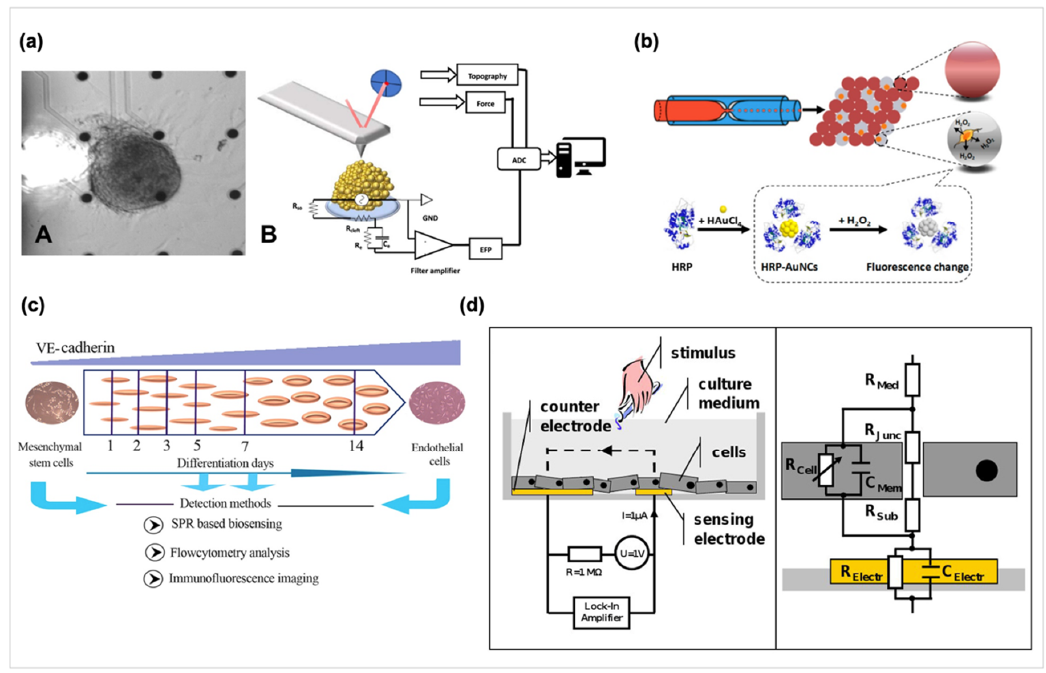
Figure 2. ( a )-A: A beating cardiac cluster placed on a microelectrode arrays (MEA) sensing area. ( a )-B: Schematic representation of the implemented setup (Reprinted with permission from [62] Copyright (2019) ELSEVIER publishing). ( b ) Schematic Illustration of Detecting Hydrogen Peroxide in the Single-Cell Encapsulated Droplets in Combination with horseradish peroxidase (HRP)-AuNCs